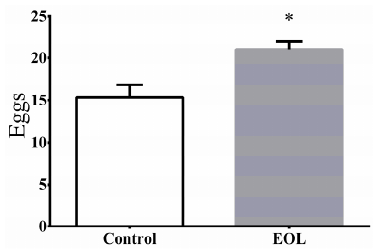
Figure 3. The eggs laid by the C. elegans . Differences were considered significant at p < 0.05 (*).